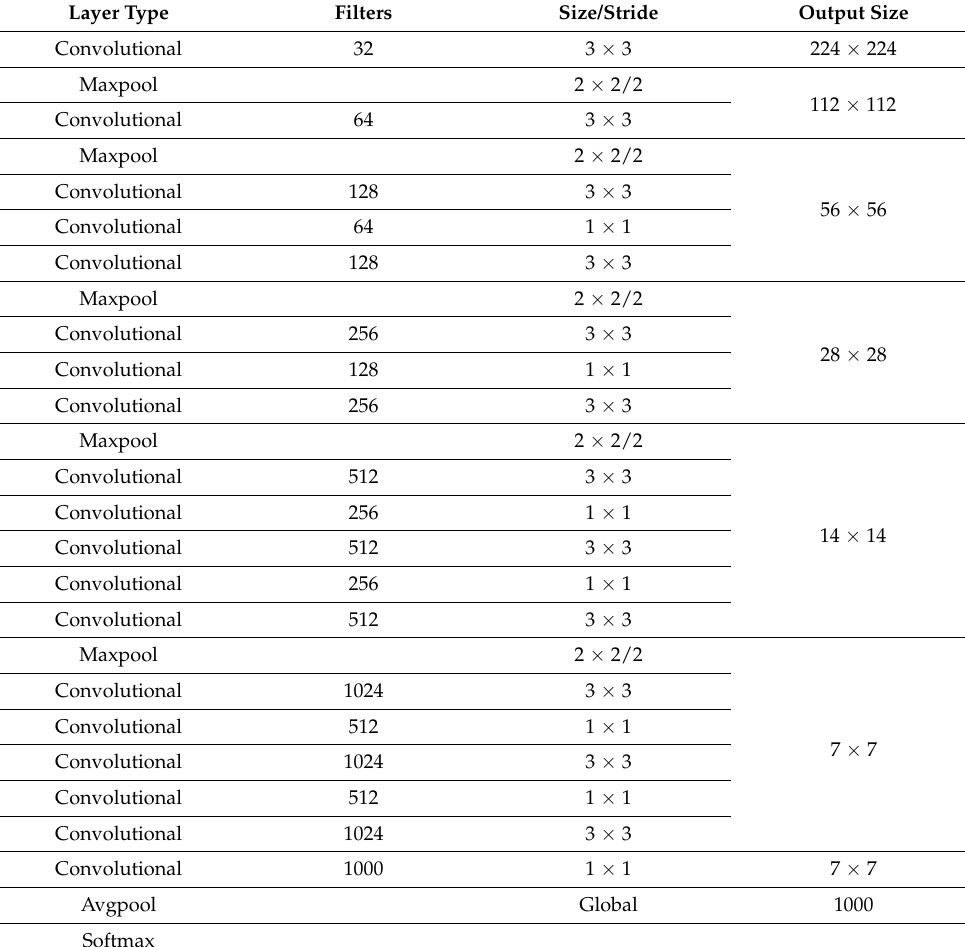
Table 3. DarkNet-19 Architecture layer parameters